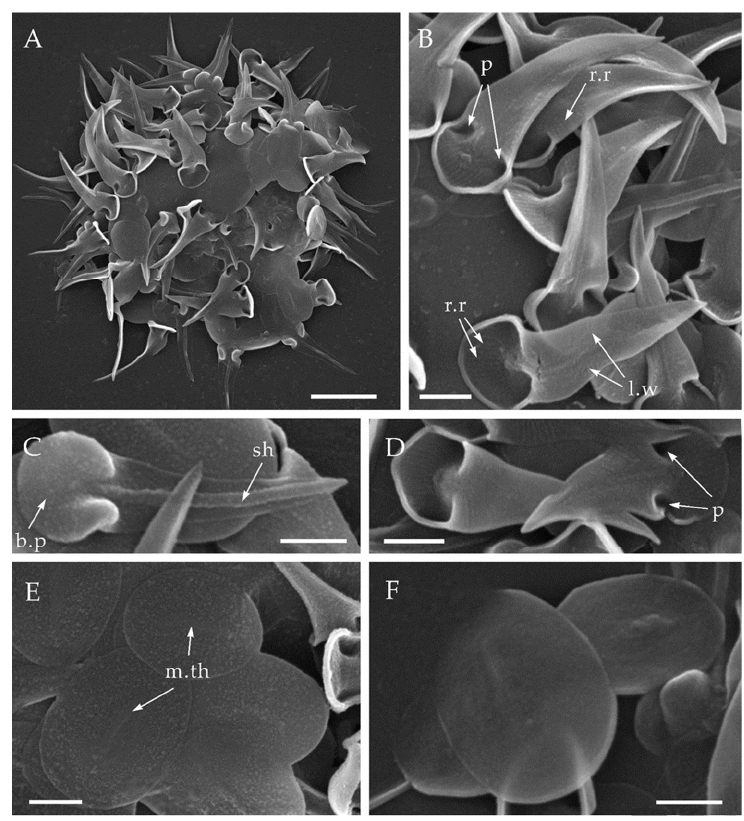
Figure 3. Triangulopteris lacunata gen. et sp. nov., strain HF-25 from the Kolyma Lowland, scanning electron microscopy. ( A )—general view of the dried cell; ( B – D )—spine scales; ( E , F )—plate scales. Abbreviations: b.p—basal plate; l.w—lateral wing; m.th—medial thickening; p—pockets; r.r—ra- dial ribs; sh—shaft. Scale bars: ( A )—2 μ m; ( B – F )—0.5 μ m.